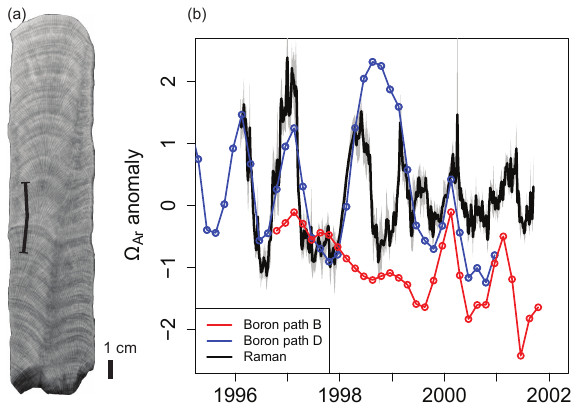
Figure 7. Time series of boron- and Raman-derived (cid:127) Ar in a coral from Havannah Island. (a) X-ray image of central slab cut from the core. The black line indicates the Raman sampling path. Boron paths B and D were located approximately 1cm into and out of the page, respectively (see Fig. 1 in D’Olivo and McCulloch (2017) for details). (b) The red and blue lines show boron-derived (cid:127) Ar assum- ing a constant [Ca 2 + ] cf . Raman-derived (cid:127) Ar is plotted in black with grey error bars indicating 1 σ . The means of the two data sets (mean of Raman (cid:127) Ar was 9.5) have been removed to facilitate compari- son and because of uncertainty of absolute [Ca 2 + ] cf for the boron calculations.